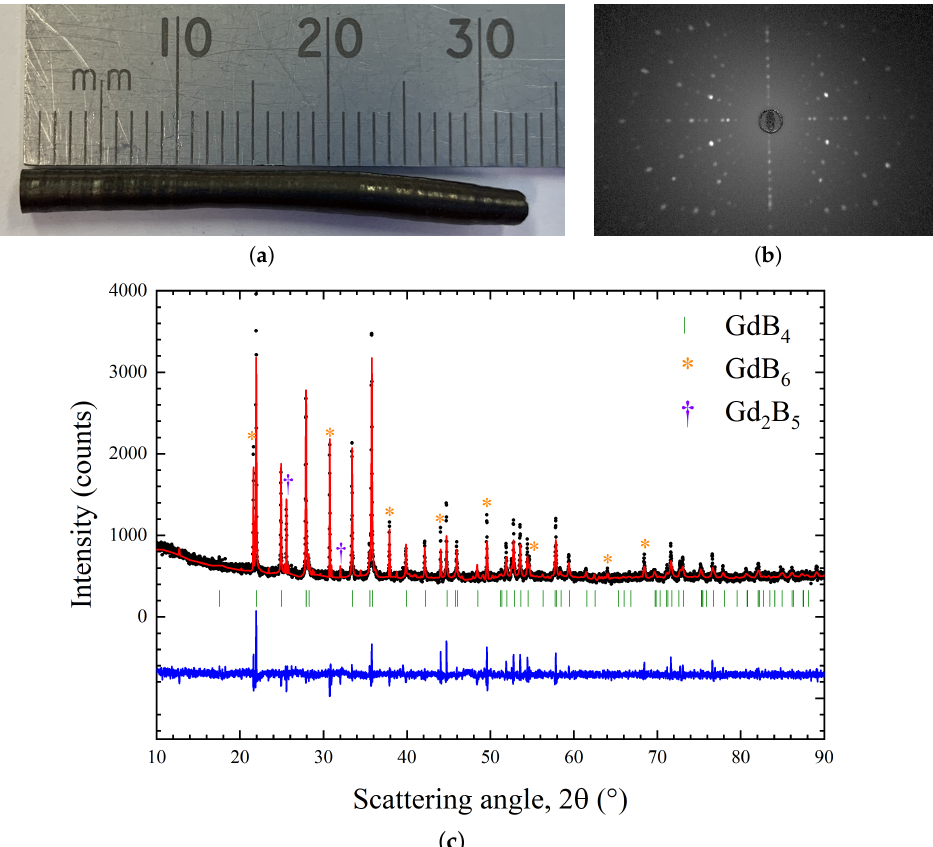
Figure 5. ( a ) Boule of GdB 4 prepared by the floating-zone method in an argon atmosphere at a growth rate of 18 mm/h. ( b ) X-ray Laue back reflection photograph of a crystal of GdB 4 , showing the [100] orientation of an aligned sample used for physical properties measurements. ( c ) Room temperature powder X-ray diffraction pattern of a ground GdB 4 crystal. The experimental profile (black closed circles) and a full profile matching refinement (red solid line) made using the P 4/ mbm tetragonal structure are shown, with the difference given by the blue solid line. The symbols * indicate the reflections belonging to a GdB 6 impurity and the † indicates a Gd 2 B 5